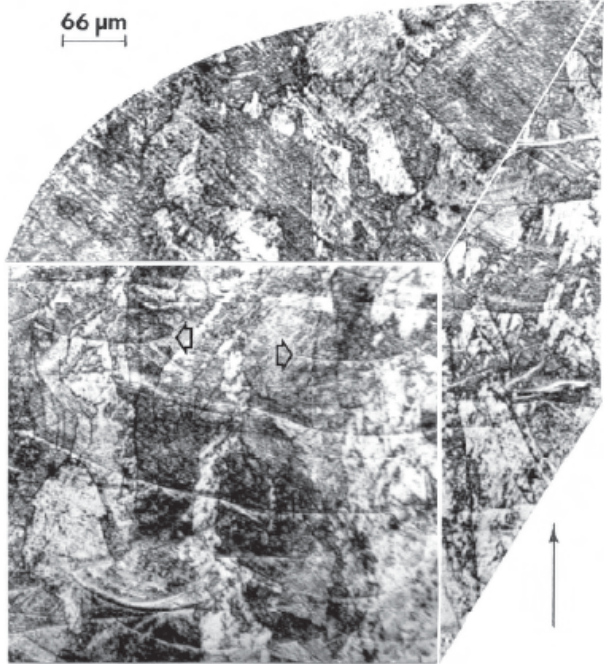
Figure 17. OM-3D reconstruction of 17-4 PH sample, effective building direction shown by vertical arrow in the lower right corner: the microstructure is mainly austenitic, with a minor volume fraction of martensite (15%) and comes from N 2 -atomized powders fabricated in a N 2 -rich environment (N 2 /N 2 ) [137].